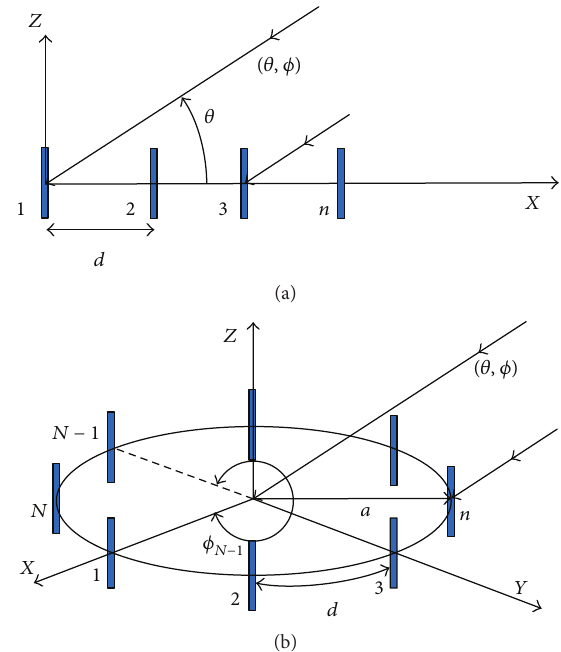
Figure 1: The antenna array geometry: (a) linear and (b)